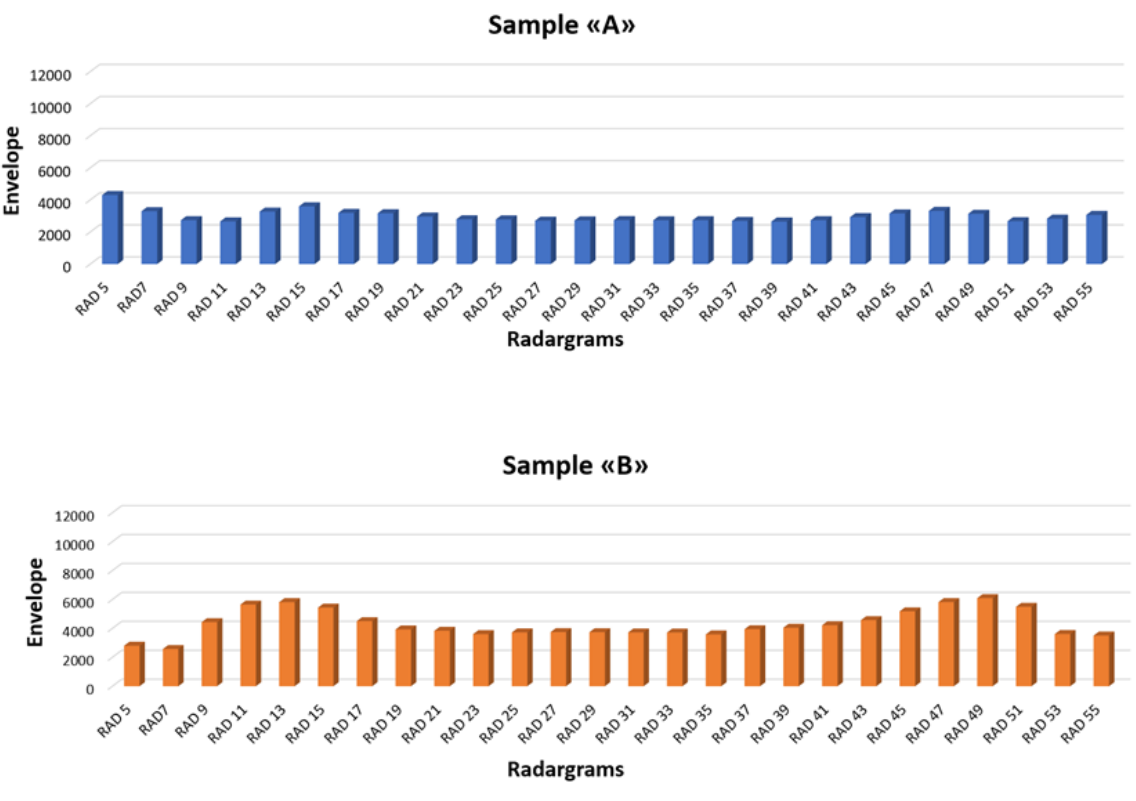
Figure 15. Envelope values along the steel rebar for sample “A” ( top ) and for sample “B” ( bottom ). Each bar of the histogram represents the average value of the envelope signal applied on all the radargrams acquired before the induced corrosion phase. Only the odd radargrams were plotted from n°5 to n°55.